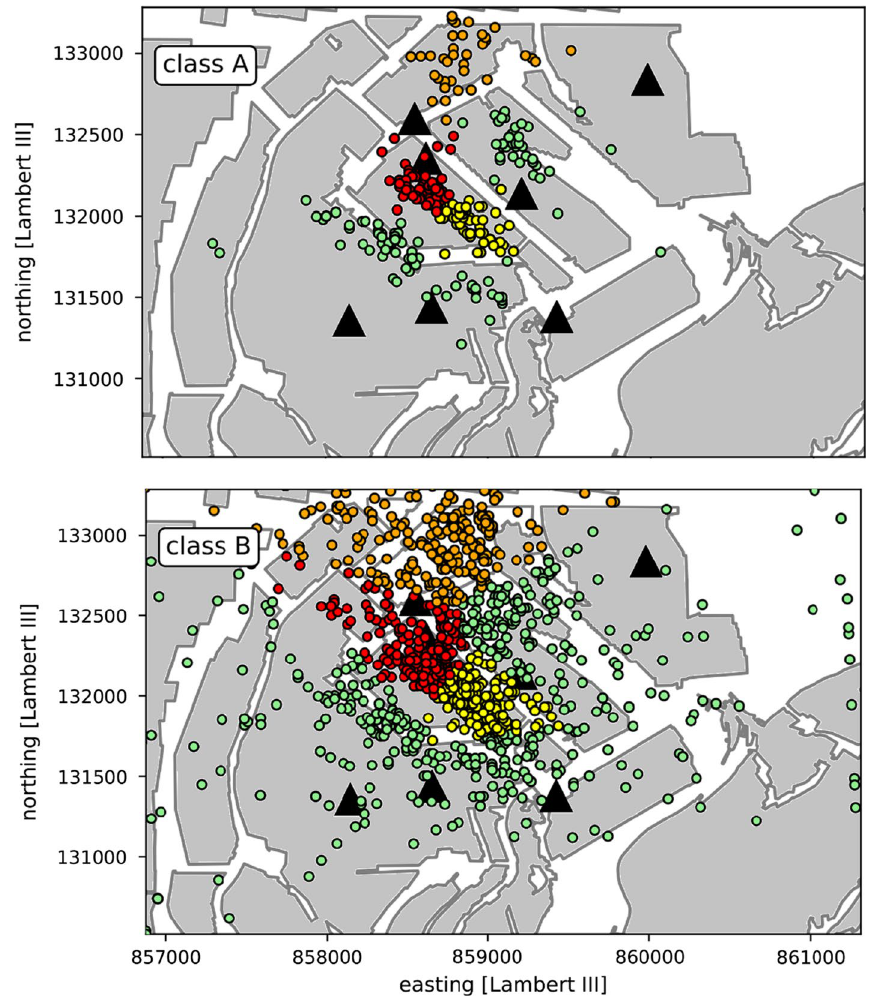
Fig. 2 Classification of the highest quality events in catalogue 2014– 2017 according to data published by Namjesnik et al (2021). Yellow (cluster A ) and red (cluster B ) are part of the “central cluster”, orange